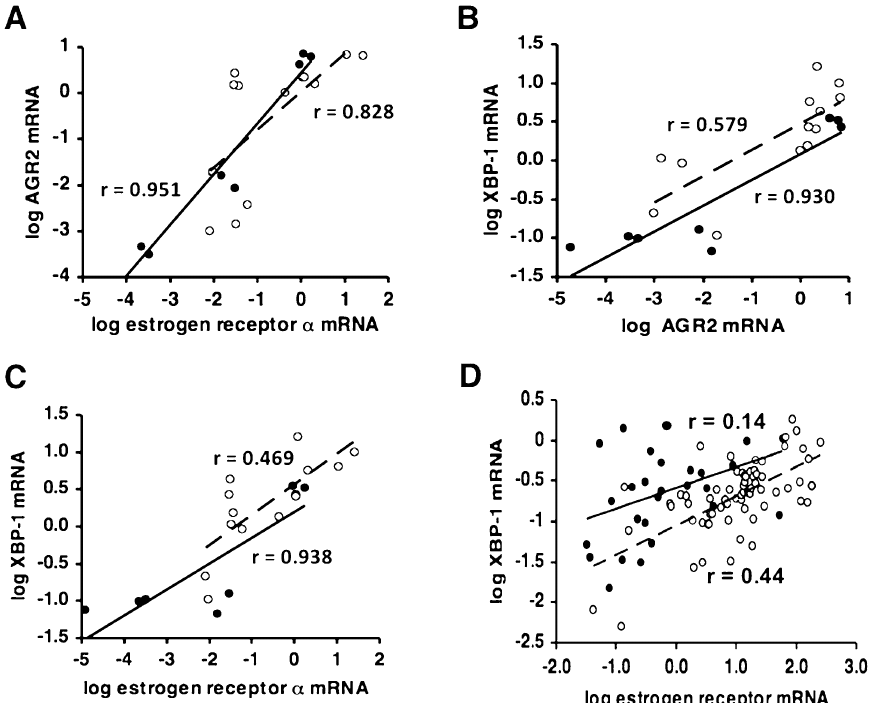
Fig. 3. Correlations between estrogen receptor α mRNA, AGR2 mRNA and XBP-1 mRNA in breast tumour cell lines and carcinoma specimens. The levels of estrogen receptor α mRNA, AGR2 mRNA and X-box binding protein-1 (XBP-1) mRNA were determined by quantitative RT-PCR in either 8 breast tumour cell lines and 13 carcinoma specimens (A, B, C), or 97 breast carcinoma specimens (D). The results were normalised against three independent constitutive mRNAs as described in Section 2. The results are plotted after logarithmic transformation for estrogen receptor α mRNA against AGR2 mRNA (A), for AGR2 against X-box binding protein (XBP-1) (B) and ER α mRNA against X-box binding protein-1 (XBP-1) mRNA (C, D). In (A, B and C), data from cell lines are shown as black circles with a solid trendline and data from carcinoma specimens is shown as white circles with a broken trend-line. In (D), the data for specimens that were ER α protein positive or negative by immunohistochemistry are shown as white circles (with broken trendline) or black circles (with solid trendline), respectively. Statistical analyses are given in the text, but Pearson coefficients (r) are shown for each